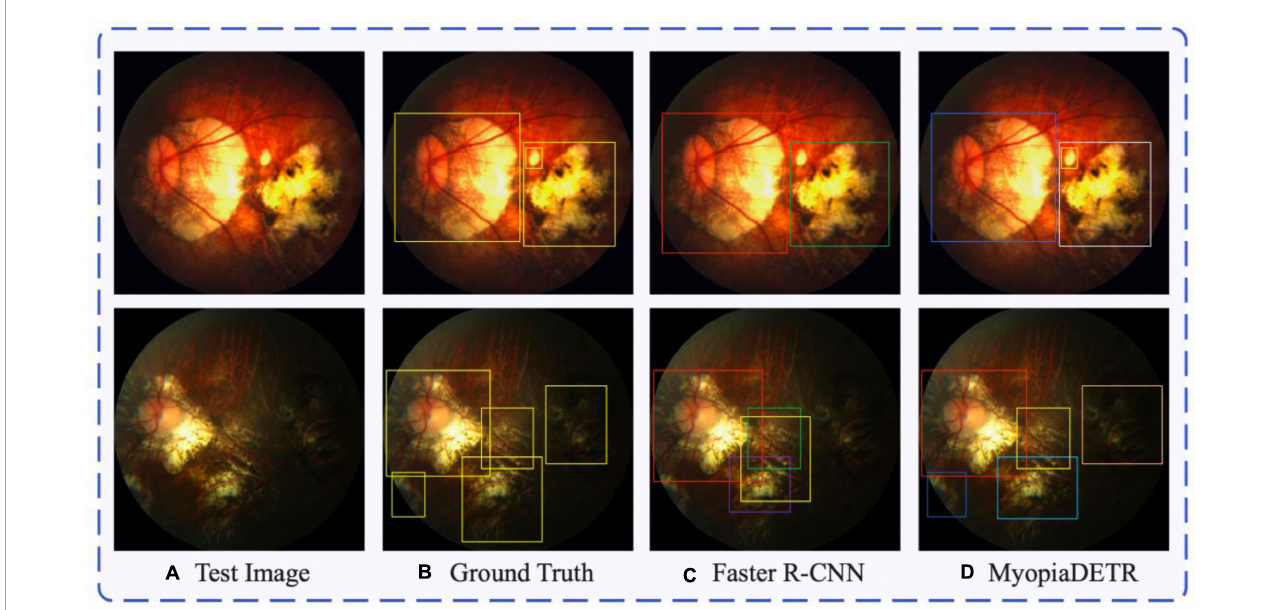
FIGURE5 The comparison between traditional object detection algorithm Faster R-CNN and MyopiaDETR. Subplot (A) shows the test image, subplot (B) shows the PM location labels, subplot (C) shows the output of the Faster R-CNN algorithm, and subplot (D) shows the output of our MyopiaDETR.